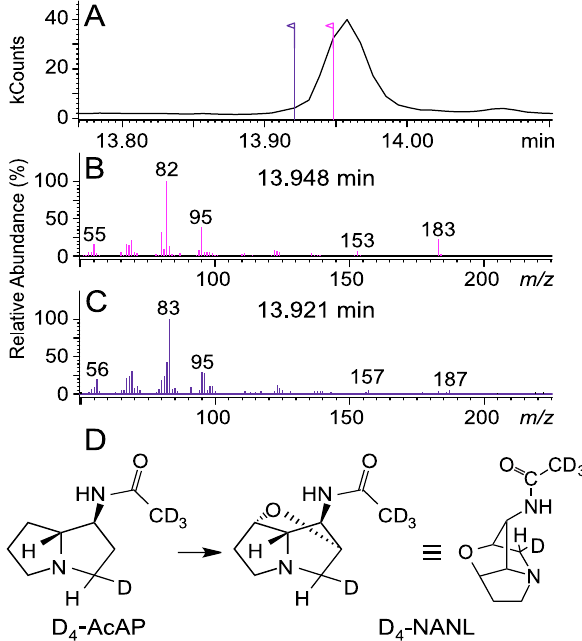
Fig. 2. Enrichment of deuterated N -acetylnorloline (NANL) from application of tetradeuterated exo -1- acetemidopyrrolizidine ([ 2 H 4 ]AcAP) to loline alkaloid producing culture. Shown are (A) GC-MS total ion chromatogram, (B) mass spectrum at retention time 13.948 and (C) 13.921 min, and (D) proposed scheme of [ 2 H 4 ]NANL formation from [ 2 H 4